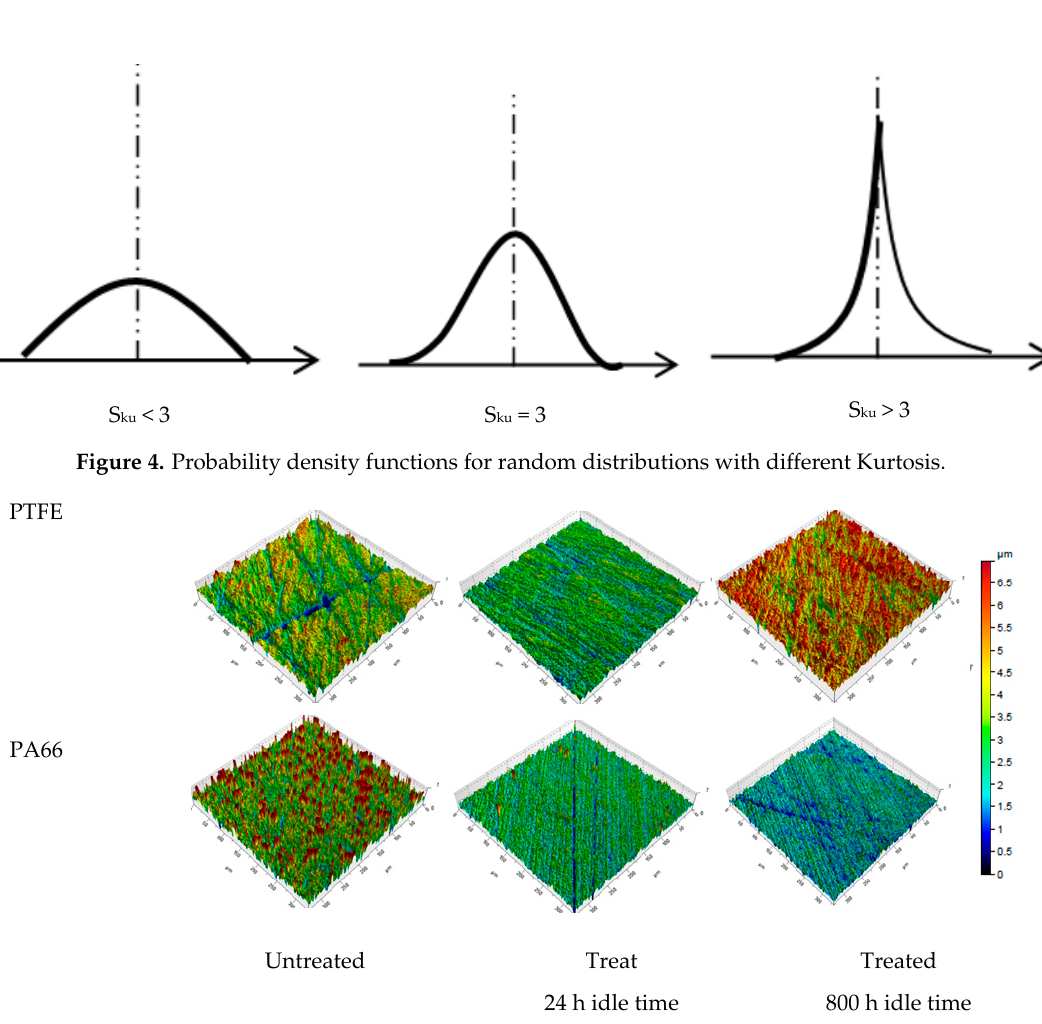
Figure 5. 3D topography of treated and untreated specimen for PA66 and PTFE grades.